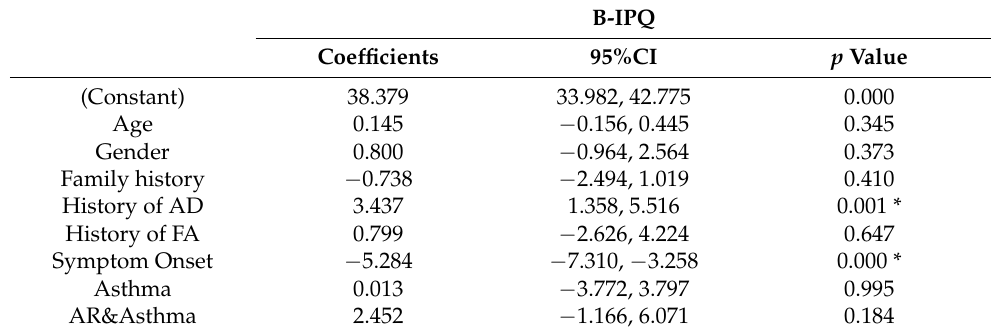
Table 2. Multiple linear regression model of B-IPQ scores in the respiratory allergy